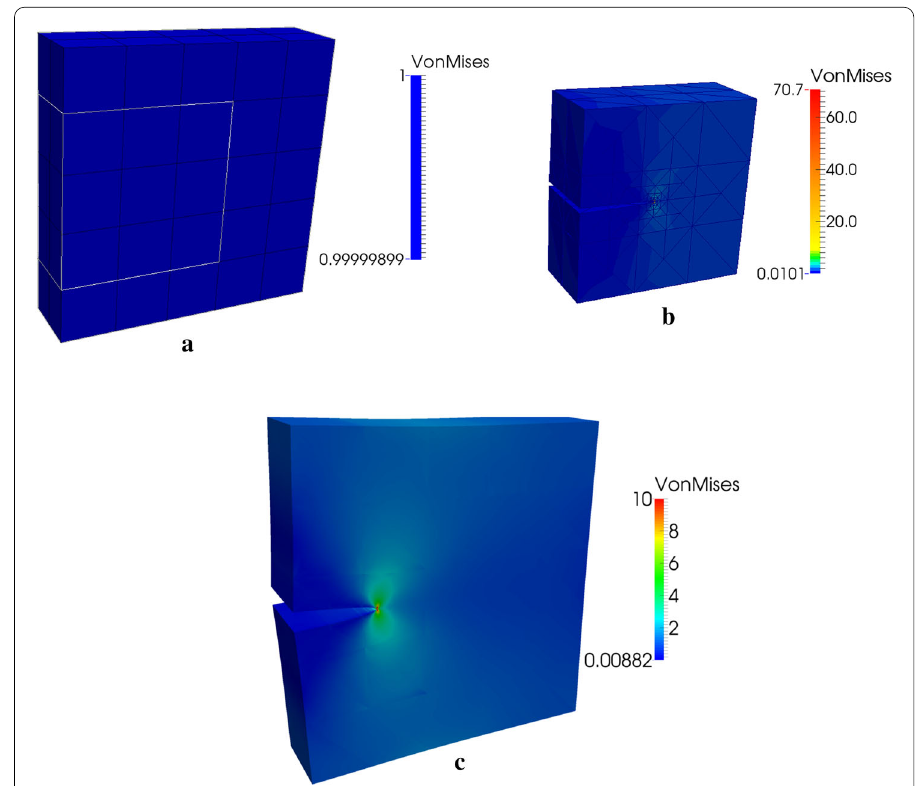
Fig. 12 Contour plots of the von Mises stress for 3-D edge crack— a initial global problem— b local problem— c enriched global problem. This is computed with Abaqus-ISET and HEX20 elements in the global